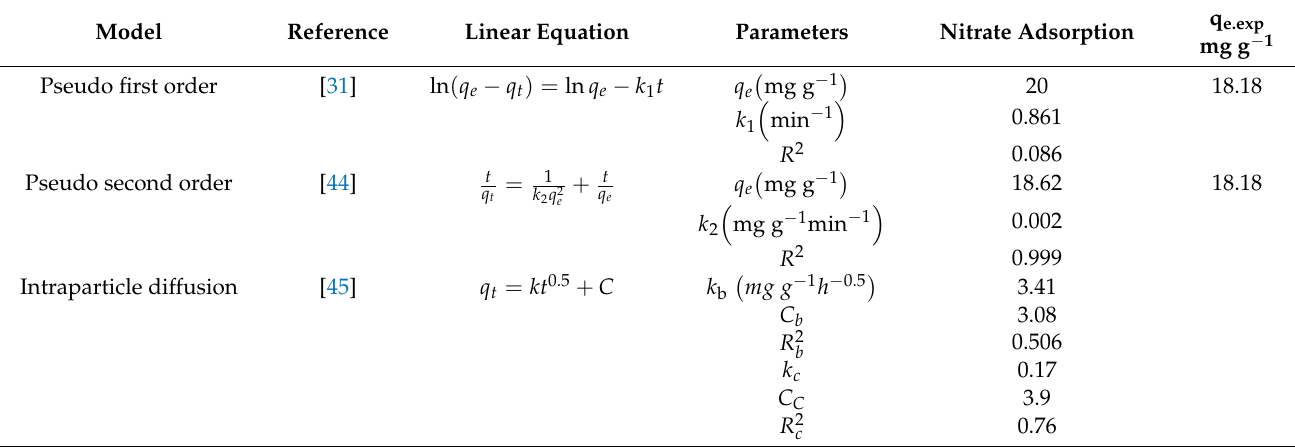
Table 1. Kinetic parameters of nitrate adsorption by SMCB/Fe.